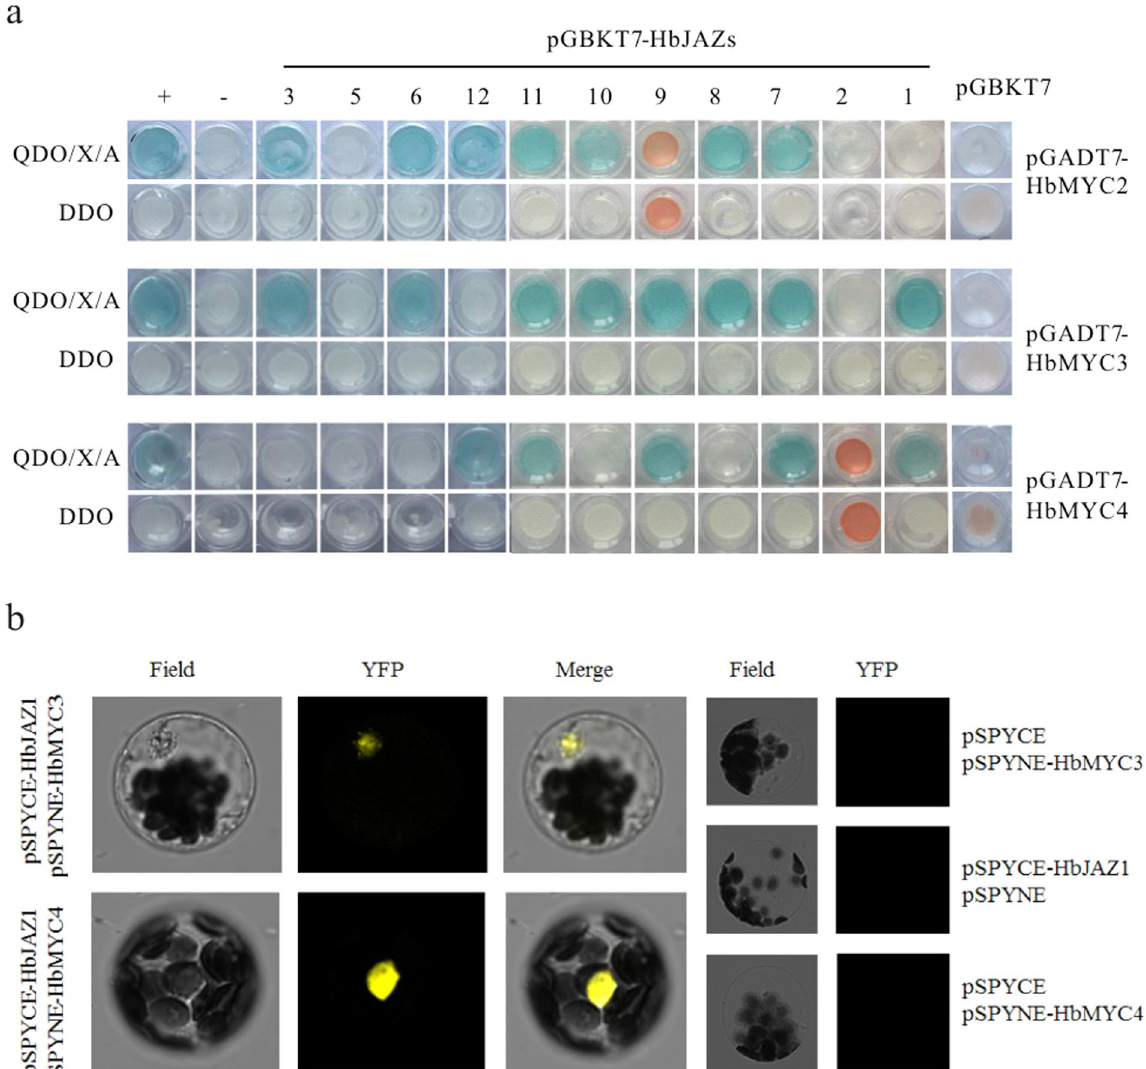
Figure 3. Interaction of HbJAZs with HbMYC proteins. ( a ) Full-length HbMYCs and HbJAZs were fused into pGADT7 and pGBKT7 vectors to generate prey and bait vectors, respectively, which were further transformed into Y187 and Y2Hgold yeast strains, respectively. The Y187 and Y2Hgold yeast strains were then combined and cultivated. The mating cells were screened on synthetic drop-out (DO) plates (SD-Trp/-Leu), and the Y2H interactions were assessed on QDO/X/A plates (SD-Trp/-Leu/-Ade/-His/X/A). Positive control mating ( + ): Y2HGold [pGBKT7-53] and Y187 [pGADT7-T]; negative control mating ( − ): Y2HGold [pGBKT7- Lam] and Y187 [pGADT7-T]. The experiments were performed in triplicate. ( b ) Detection of the interaction between HbJAZ1 and HbMYCs by bimolecular fluorescence complementation. The plasmid combinations of pSPYCE-HbJAZ1 and pSPYNE-HbMYC3 or pSPYCE-HbJAZ1 and pSPYNE-HbMYC4 were co-transferred to Arabidopsis thaliana protoplasts, and the yellow fluorescence was observed by laser confocal